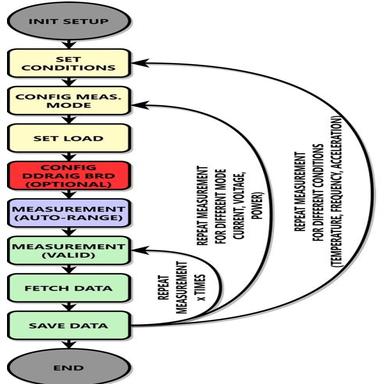
General flow diagram of an experiment routine with the sequential steps followed by the software to perform an experiment. Initial and final setup are marked in grey elliptical blocks. Setting the experiment conditions in first three blocks is marked in yellow; configuration of optional control board marked in red; following measurement step in auto-range mode marked in purple; final data measurement and saving steps marked in green. Testing ranges, such as i.e. frequency sweep, is delivered with the loopin